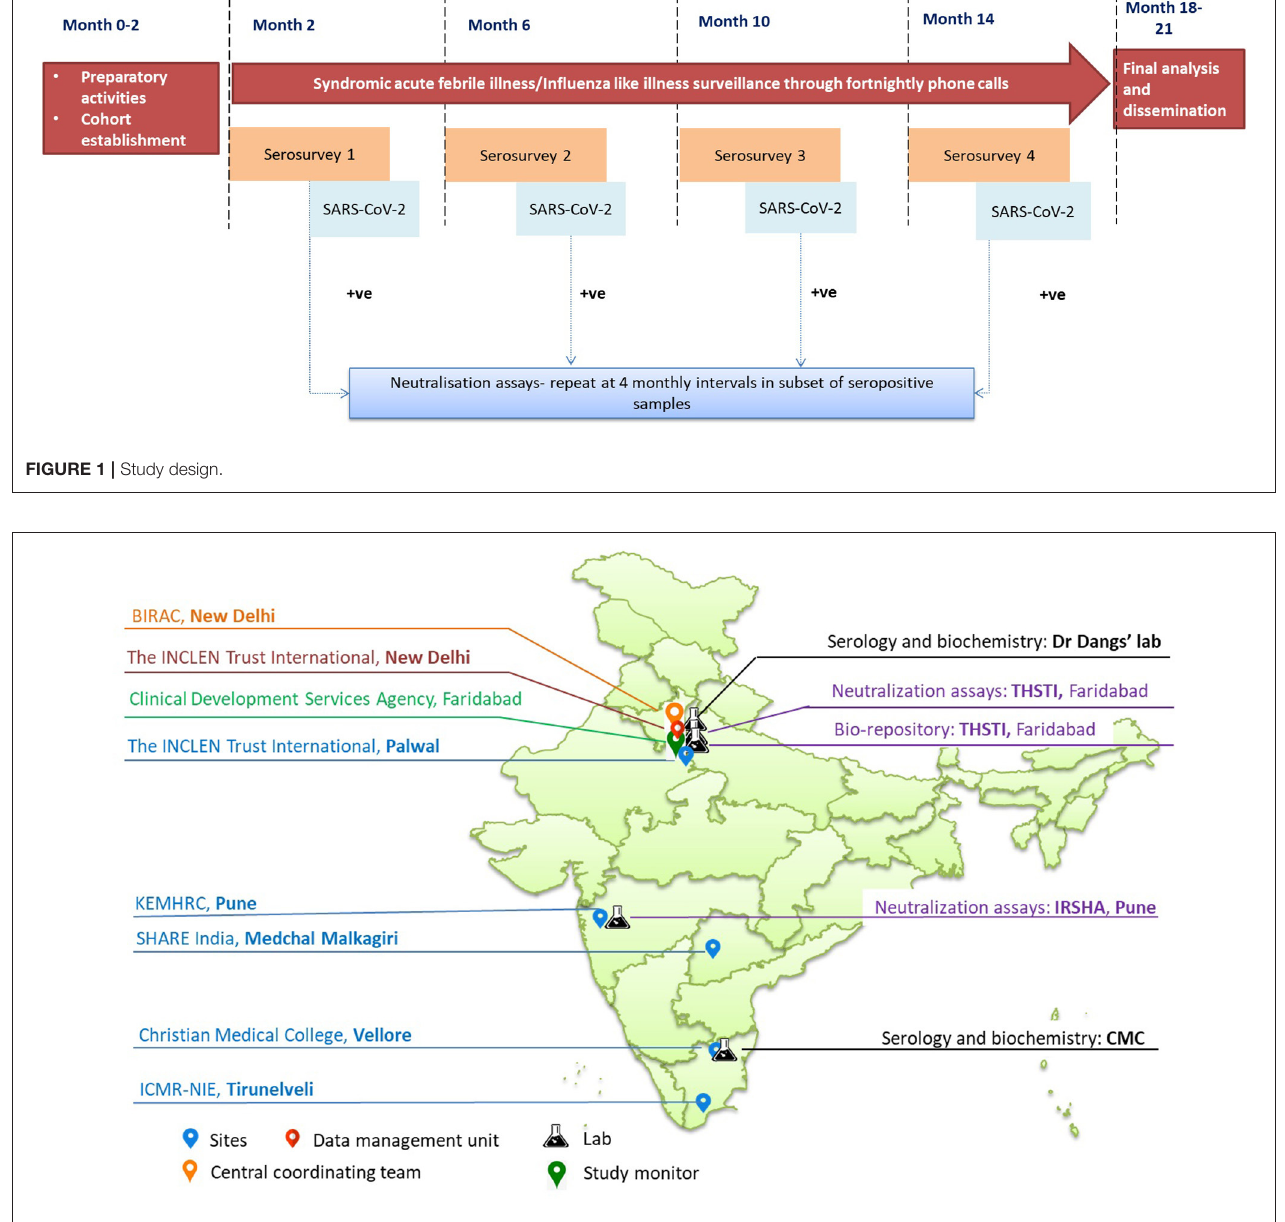
FIGURE 2 | Study sites and laboratory